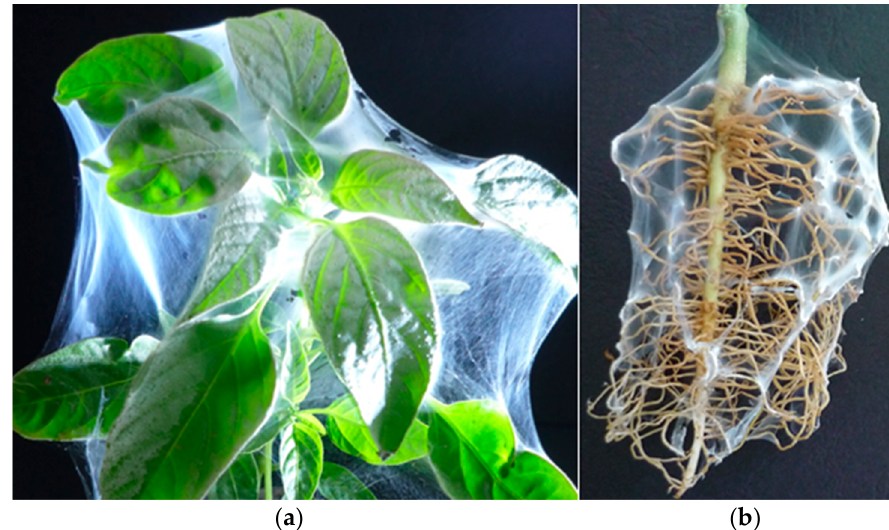
Figure 6. Biohybrid fibers directly electrospun on capsicum leaves and root system. The morphology of the obtained PLLA and PLLA mat coated with film of chitosan with different molecular weight (oligochitosan, low-molecular-weight chitosan (LMW) and high-molecular-weight chitosan (HMW)) and T. asperellum spores are presented in Figure 7. The diameters of the PLLA fibers were 1260 ± 192 nm. Formation of a chitosan